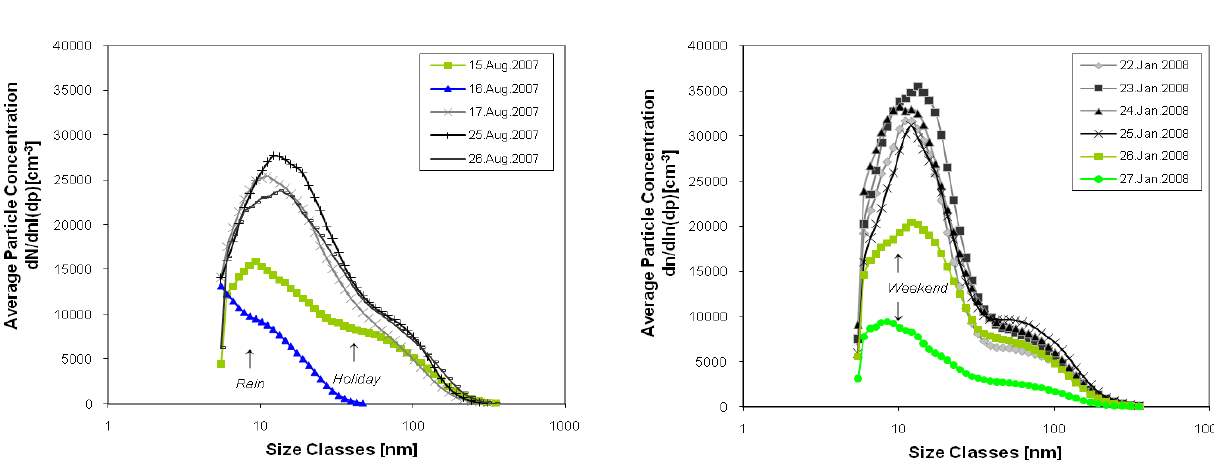
Figure 2 . UFP size distribution of daily averages at the rural site along the motorway A10. Left panel: summer measurement, right panel: winter measurement. Significant drop of UFP on weekend/holiday and weather-influence is